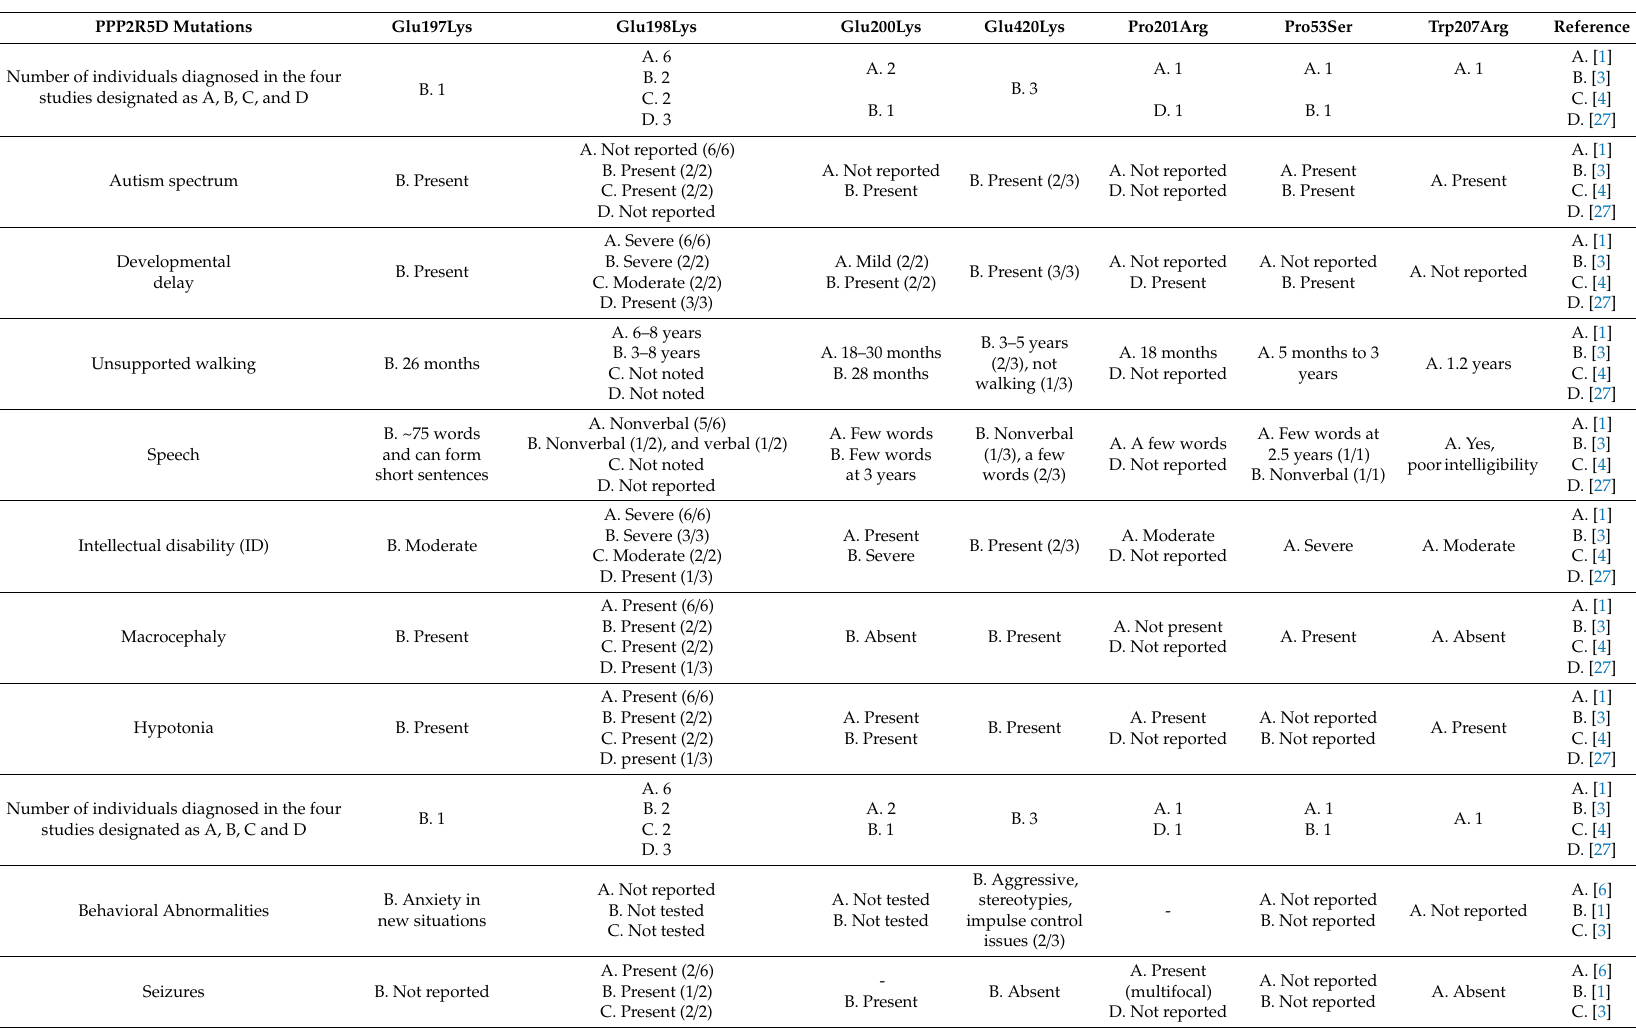
Table 1. Clinical features of individuals with di ff erent de novo mutations in the Protein Phosphatase 2 Regulatory Subunit B (cid:48) Delta ( PPP2R5D ) gene. PPP2R5D Mutations Glu197Lys Glu198Lys Glu200Lys Glu420Lys Pro201Arg Pro53Ser Trp207Arg Reference Number of individuals diagnosed in the four studies designated as A, B, C, and